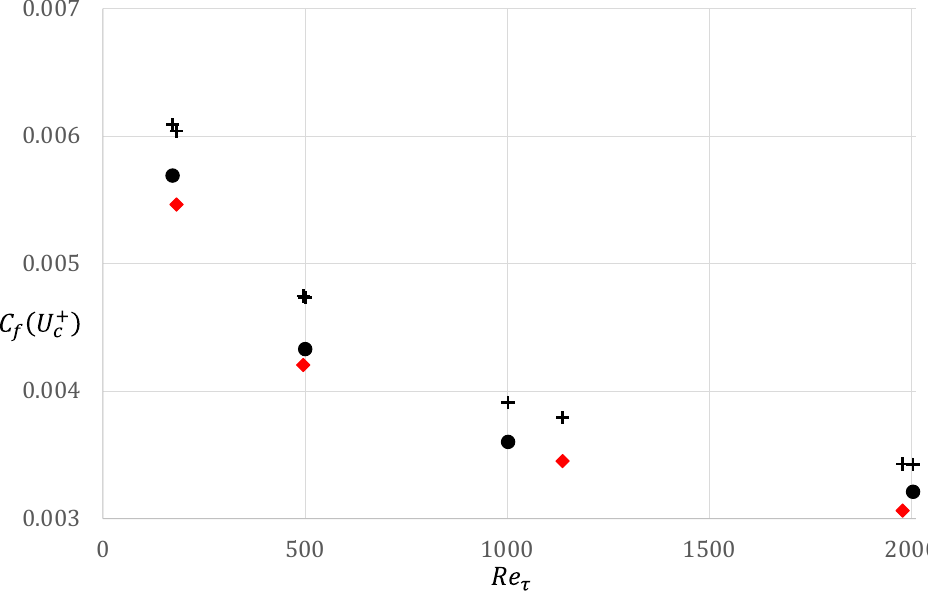
pipe DNS data [31,32]; and + ♦